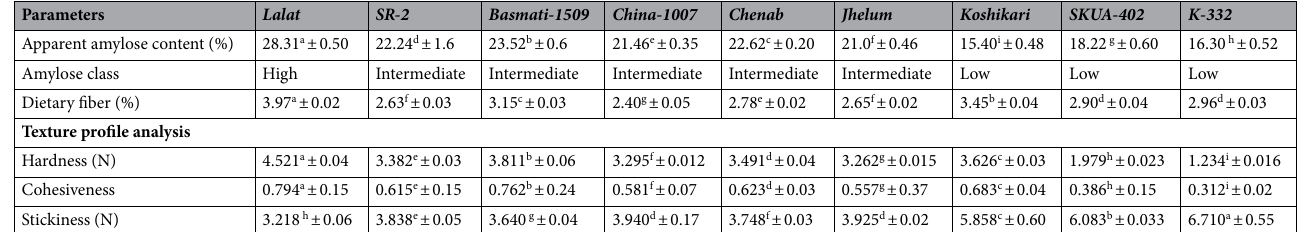
Table 2. Apparent amylose content, dietary fiber and textural parameters of different rice genotypes. Results are expressed as mean ± SD of three replications. Mean values in the rows with different superscripts are significantly different at p ≤